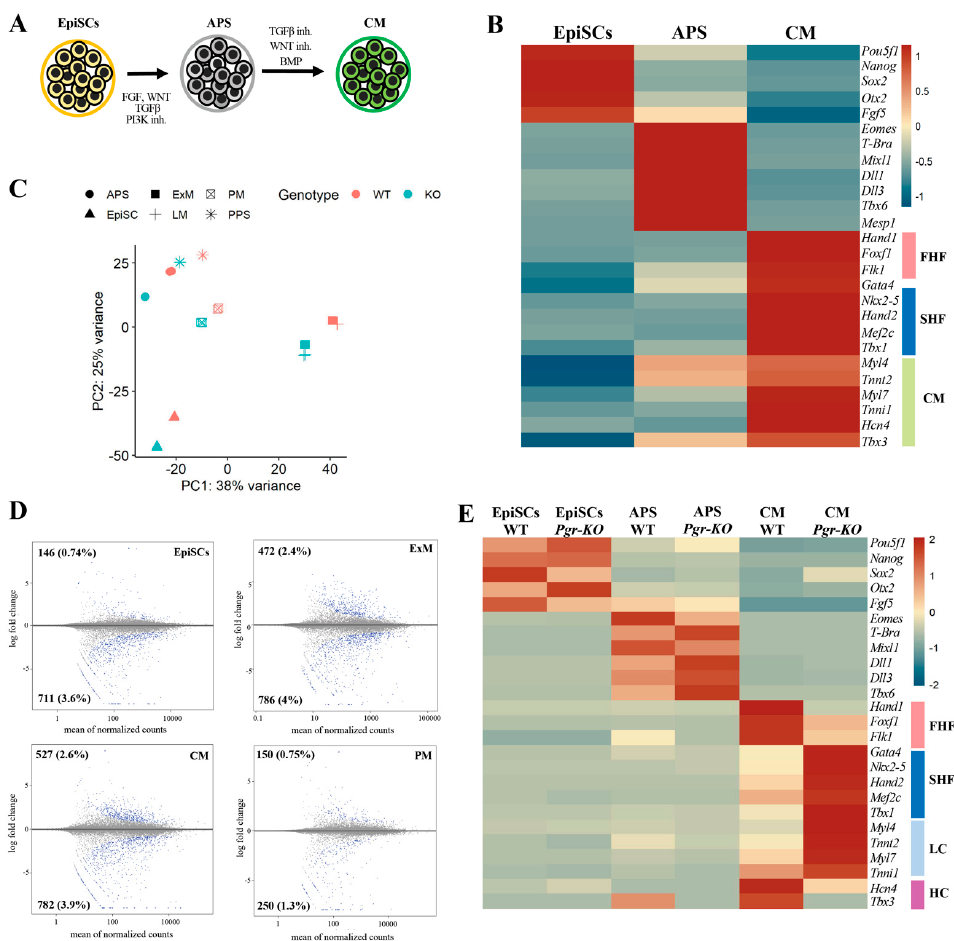
Figure 4. PGR differentially regulates FHF and SHF cardiac progenitors. ( A ) Schematic illustration of the cardiac mesoderm (CM) differentiation protocol. EpiSCs are initially subjected to APS induction, and thereafter exposed to BMP for 24 h to induce CM differentiation. ( B ) Heatmap displaying relative expression of selected differentially regulated genes in EpiSCs, APS, and CM (RNA-Seq, p ≤ 0.05, fold- change ≥ 1.5). ( C ) PCA plots clustering WT and Pgr-KO cells subjected to differentiation conditions: EpiSCs, PPS, APS, extraembryonic mesoderm (ExM), cardiac mesoderm (CM), and paraxial meso- derm (PM). CM and ExM are affected to a higher extent by Pgr depletion. ( D ) MA plots of WT and Pgr-KO comparisons in EpiSCs, ExM, CM, and PM showing the highest number of differentially ex- pressed genes in CM and ExM. Blue dots indicate differentially expressed genes with p ≤ 0.05, fold- change ≥ 1.5 ( E ) Differential expression analysis of WT and Pgr-KO EpiSCs differentiated towards APS and CM, showing modest effects of loss of Pgr on APS induction, but stronger consequences within CM differentiation. In CM, the FHF cardiac markers ( Hand1 , Flk1 , and Foxf1 ) are downregulated, while the SHF markers ( Gata4 , Nkx2-5 , Hand2 , Mef2 , and Tbx1 ) are upregulated, revealing a propension of Pgr-KO cells to acquire a cardio-pharyngeal fate. First heart field (FHF, ligh pink), second heart field (SHF, blue), late cardiomyocytes (LC, light blue), and heart conductive (HC) makers (pink).